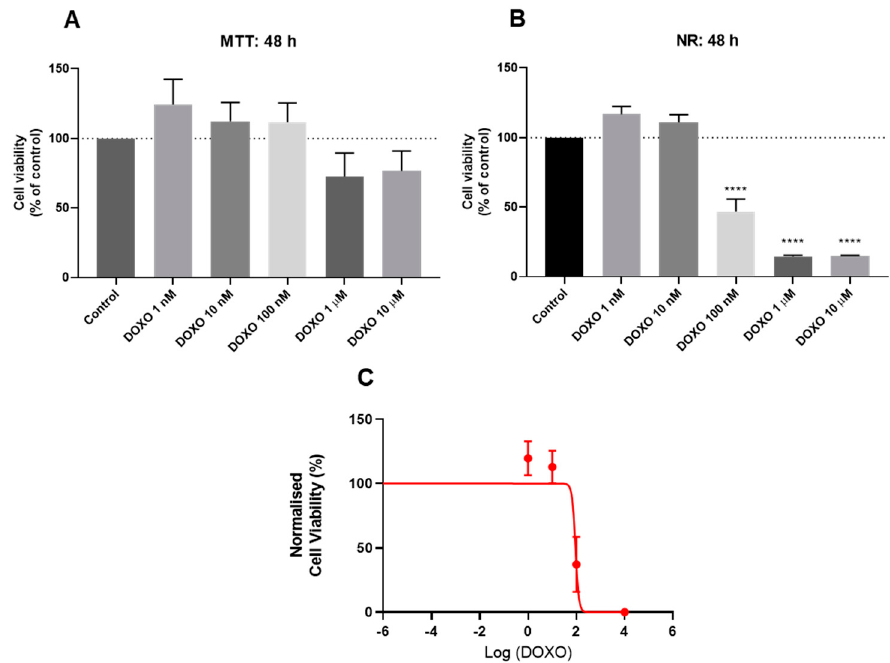
Figure 7. Effects of DOXO on the viability of SH-SY5Y neuroblastoma cells determined by ( A ) MTT and ( B ) NR assays. Based on the results of the NR assay, a dose-response curve was calculated ( C ). Cells were treated with increasing concentrations of DOXO for 48 h. The results are shown as the percentage of the control and are expressed as the mean ± SEM of four independent experiments ( n = 4). **** Statistically significant vs. the control at p < 0.0001.